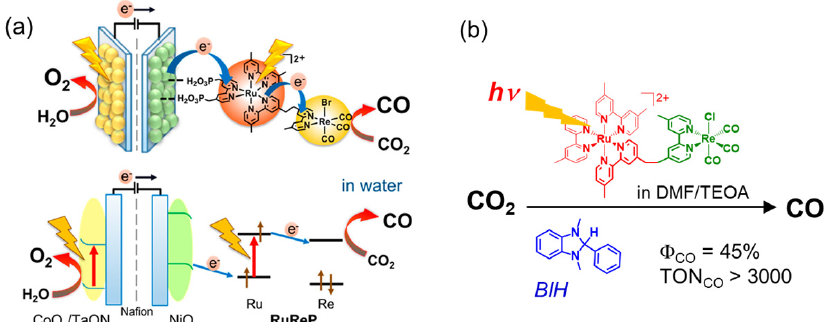
Figure 1. ( a ) An artificial Z-scheme photocatalyst combining semiconductors and a Ru–Re complex for photocatalytic CO 2 reduction using water as an electron donor. Adapted with permission from [16]. Copyright 2019 American Chemical Society. ( b ) A photocatalyst evaluation system for the Ru–Re complex using a sacrificial reducing reagent